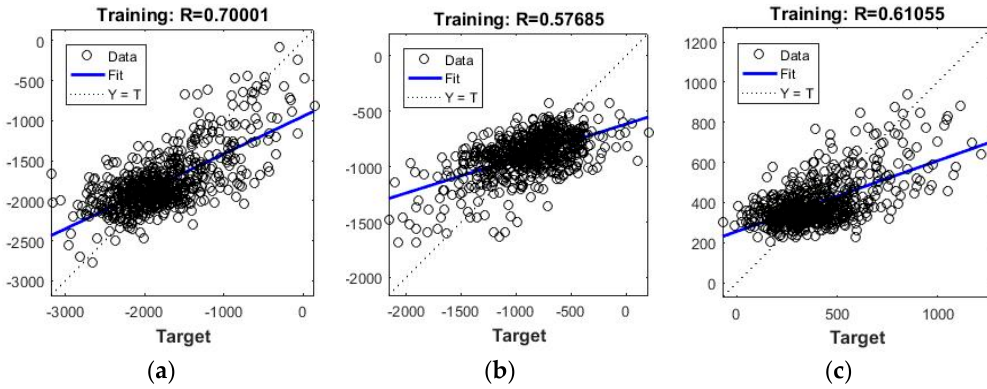
Figure 8. BNN two hidden layers fitting results based on the 85% of the samples: ( a ) Group of multispectral bands, multispectral and hyperspectral vegetation indices against GPR slice depth between 0.00–0.20 m; ( b ) Group of multispectral bands, multispectral and hyperspectral vegetation indices against GPR slice depth between 0.20–0.40 m; and ( c ) Group of multispectral bands, multispectral and hyperspectral vegetation indices against GPR slice depth between 0.40–0.60 m.